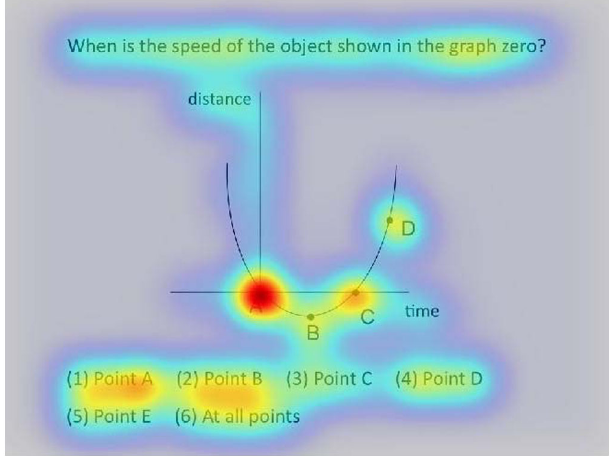
FIG. 3 (color online). Itti, Niebur, and Koch saliency map for problem 3. The perceptually salient AOI overlapped the novicelike AOI, which was at the origin of the graph.